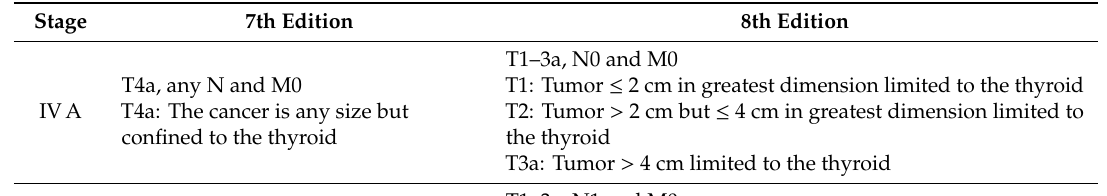
Table 1. Revisions made by the 8th edition of the American Joint Committee on Cancer / Union for International Cancer Control tumor–node–metastasis (AJCC / UICC TNM) classification system of anaplastic thyroid cancer (ATC).